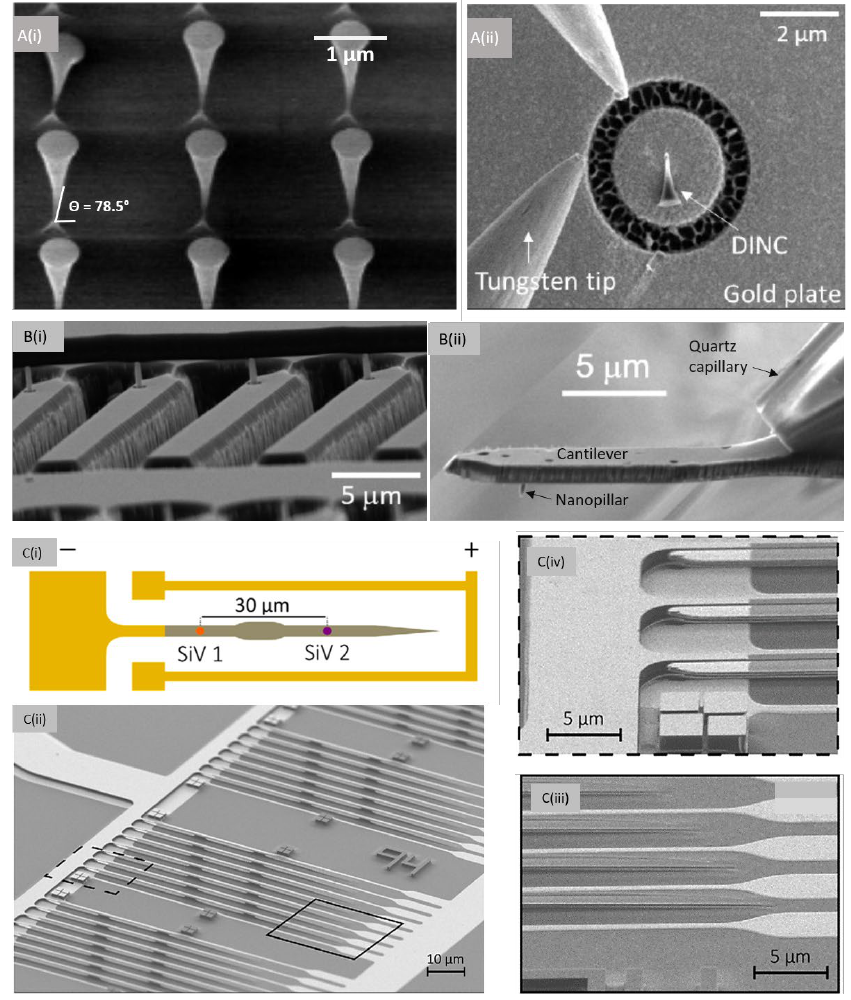
Figure 4. SEM images of ( A ) (i) Diamond inverted nano-cones (DINC) realized via a combination of E-beam lithography and angled dry etching (ICP-RIE) using a conical faraday cage. (ii) Transfer of DINC onto a gold target plate using tungsten tips for coupling of DINCs to other photonic components. Reprinted (adapted) with permission from Ref. [58]. Copyright (2020) American Chemical Society. ( B ) (i) An array of monolithic diamond scanning probes fabricated using multiple E-beam lithography and dry etching processes. The shown nanoprobes required back side diamond etching for release of the devices. (ii) Final released device consisting of a cantilever with nanopillar, attached to a quartz capillary which acts as a holder for mounting the device to a scanning probe microscope. Images reprinted from Ref. [59] under creative com- mons CC BY 4.0 license. ( C ) (i) Schematic representation of a diamond nanophotonic device where the gray region repre- sents the diamond waveguide implanted with SiV centers at defined locations, while the yellow stripes represent the electrodes to form a capacitor. On application of bias voltage between the device (-ve terminal) and the bottom (+ve ter- minal), the doubly clamped cantilever is deflected and results in localized tuning of the color center. (ii) SEM image of the photonic device realized using a combination of E-beam lithography and angled etching technique of diamond substrate.